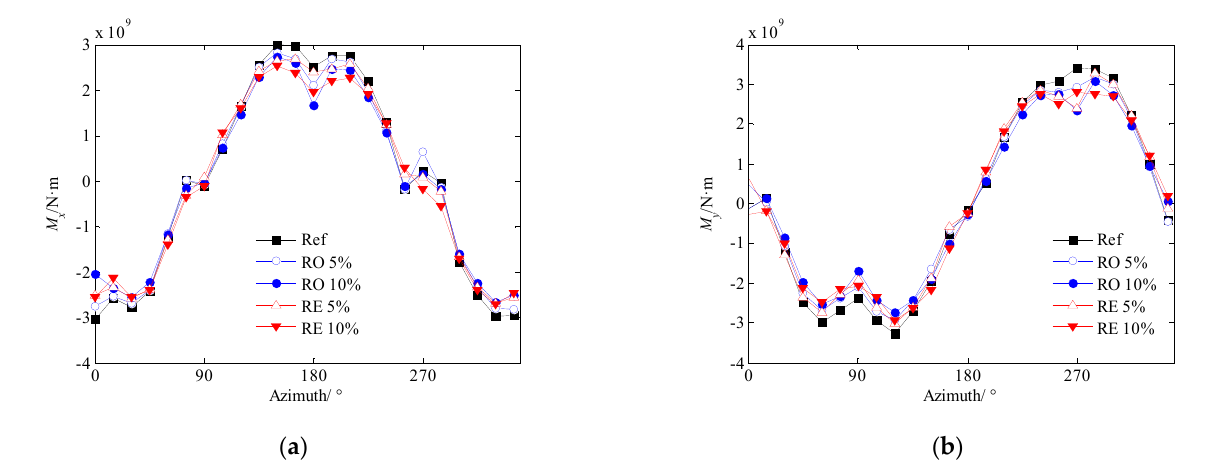
Figure 3. Mean values of base overturning moment: ( a ) M x . ( b ) M y .